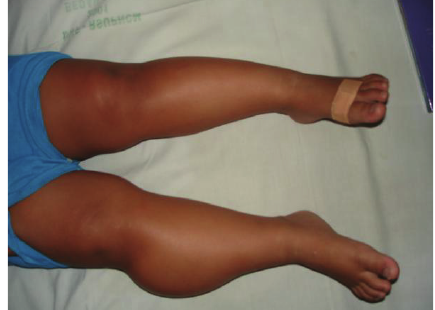
Figure 6: Clinical picture of the mass on lateral side of right lower leg in Case 2.